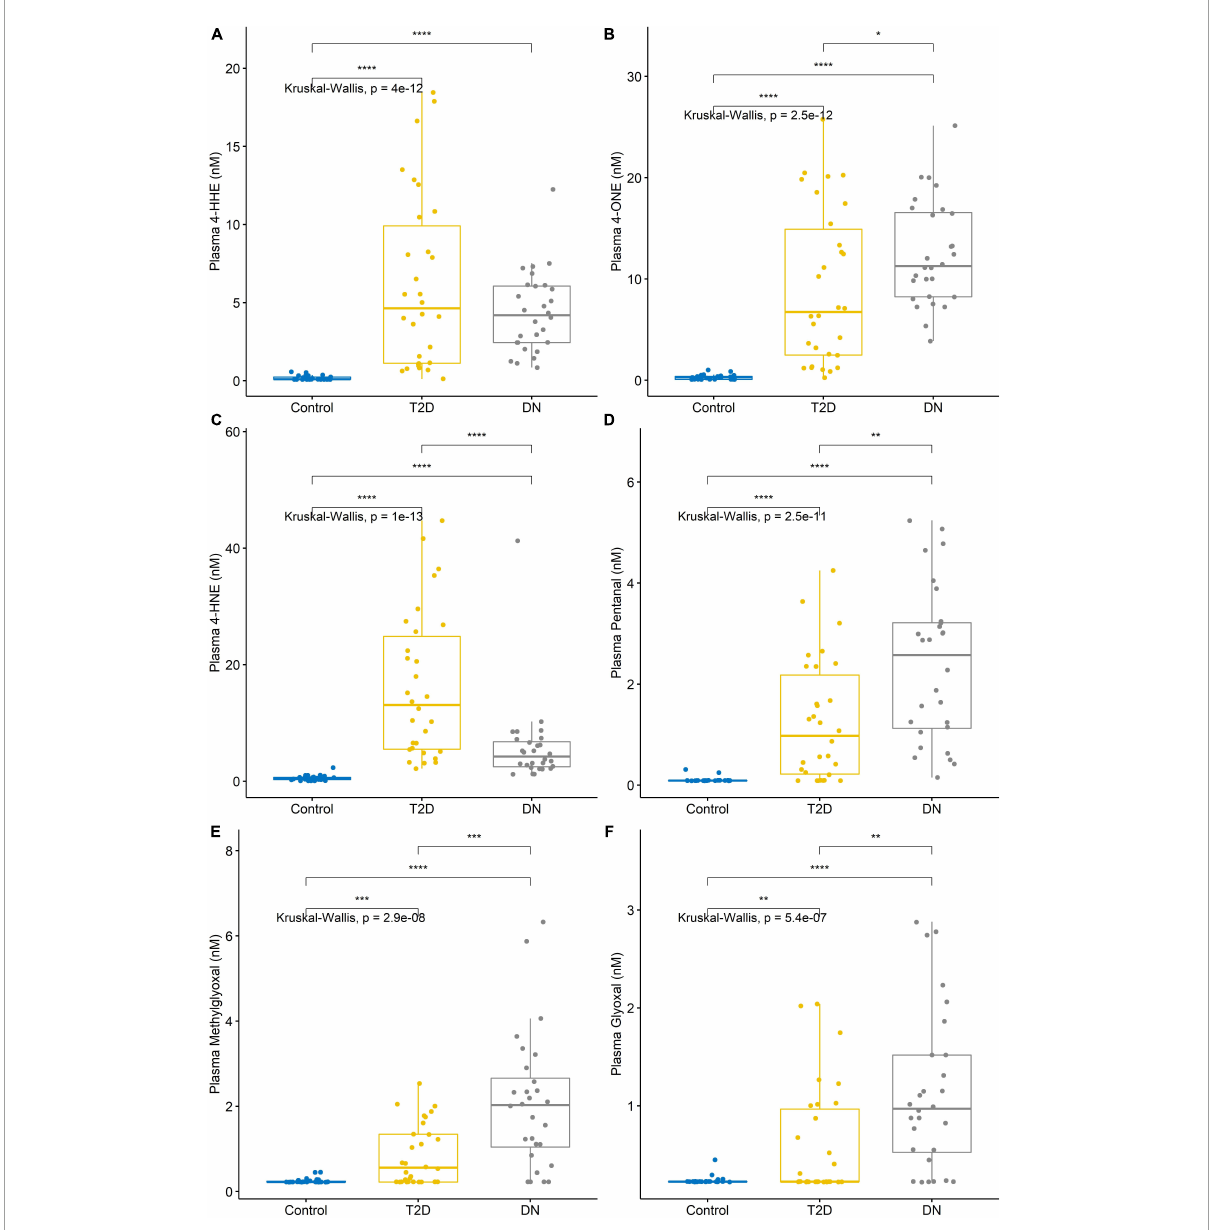
FIGURE4 Reactive aldehyde plasma levels across control, type-2 diabetic mellitus (T2DM) and diabetic nephropathy (DN) groups (A) 4-hydroxynonenal (4-HHE), (B) 4-oxo-2-nonenal (4-ONE), (C) 4-hydroxyhexenal (4-HNE), (D) pentanal, (E) methylglyoxal, (F) glyoxal. Stars of significance * p < 0.05, ** p < 0.01, *** p < 0.001, and **** p <